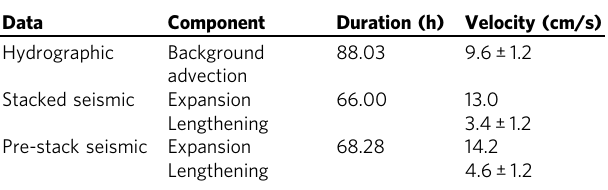
Table 2 List of velocity components (advection rate plus lengthening rate equals expansion rate) of the water interface shown in Fig.